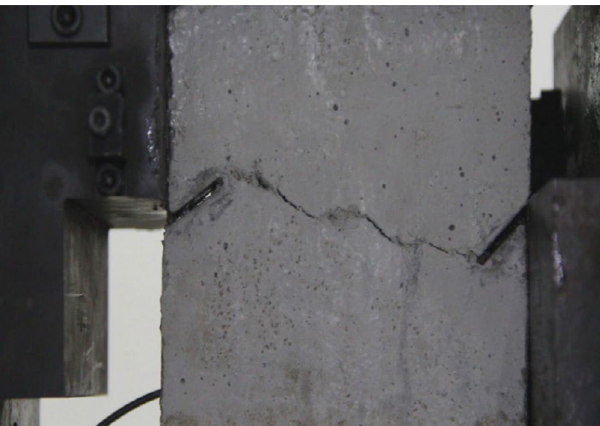
Figure 21. Photograph of a specimen showing fractures penetration.